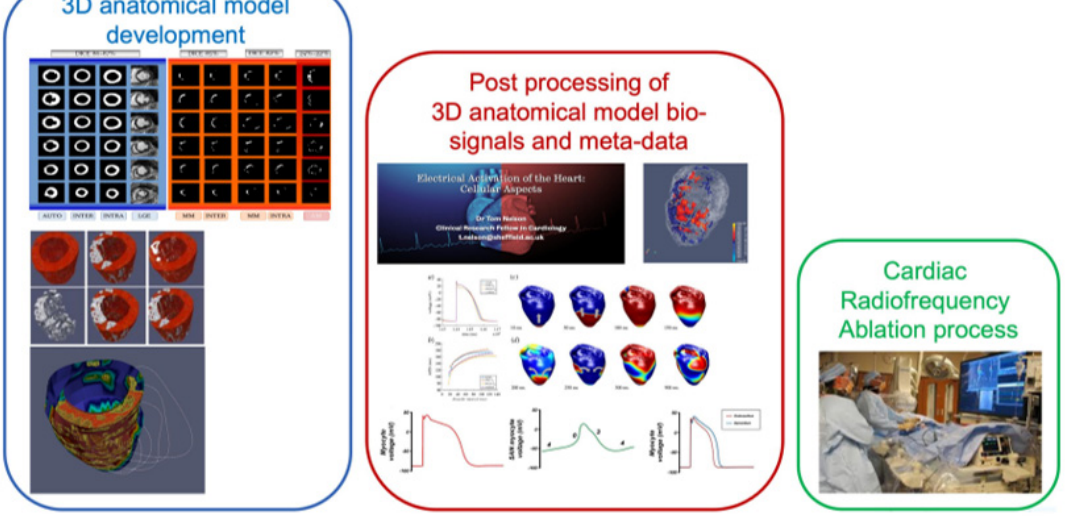
Figure 2. 3D anatomical model framework to assess cardiac arrhythmia risk [51].